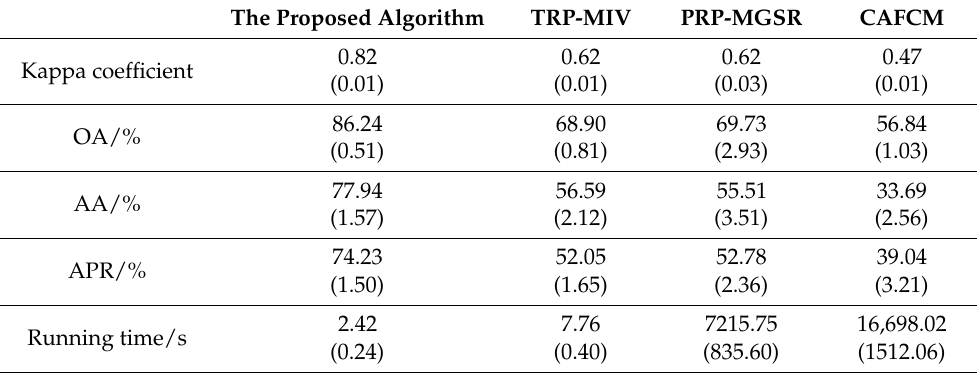
Table 6. Accuracy evaluation of classification results for the LongKou image. (The values in brackets are the variance of 100 trials, and those not in are the